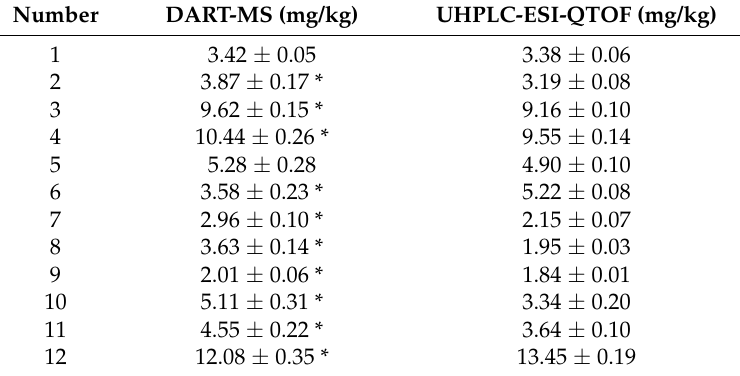
Table 4. The SPD content of beans by DART-MS versus UHPLC-ESI-QTOF methods (average ±